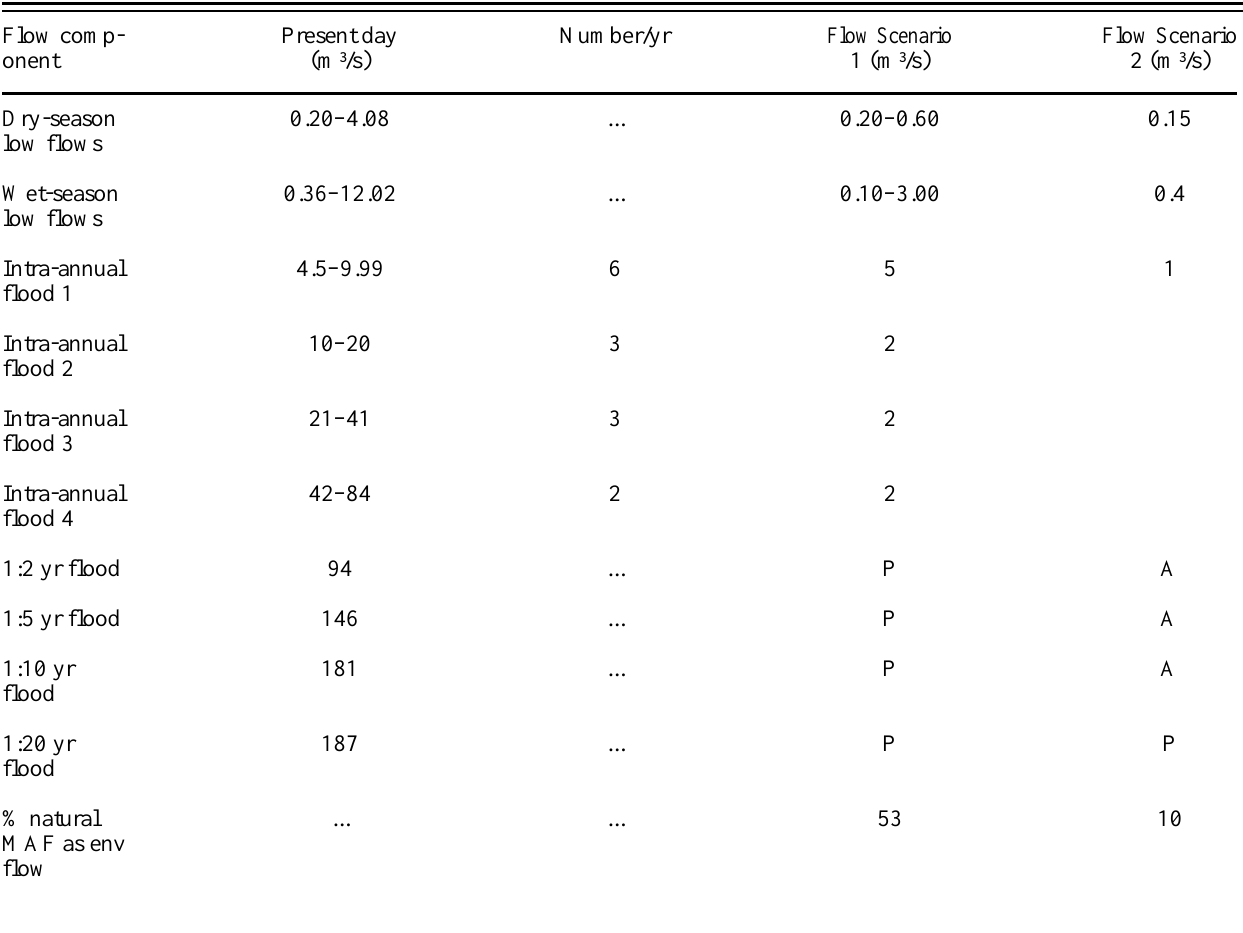
Table 2 . Possible new flow regimes linked to a planned dam for the site described in Table 1. MAF = mean annual flow, env flow = environmental flow released downstream for river maintenance, P = present, A = absent (Brown and King